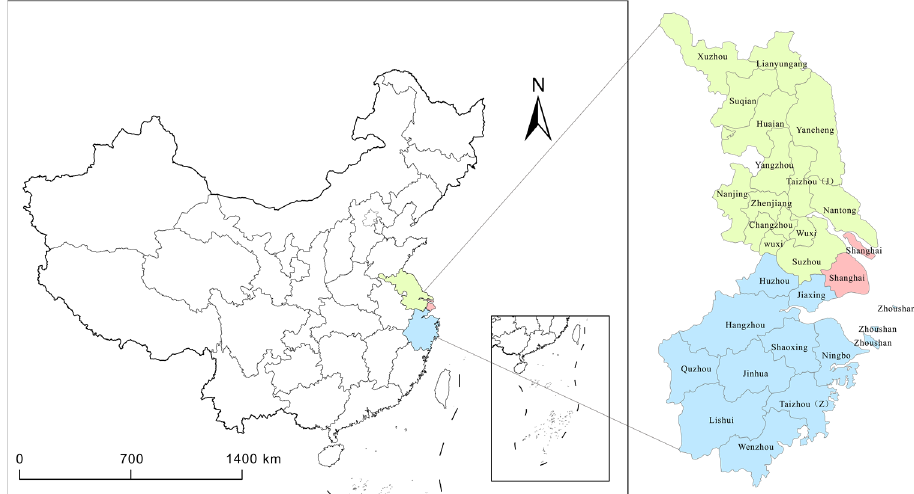
Figure 1. Overview map of the Yangtze River Delta.